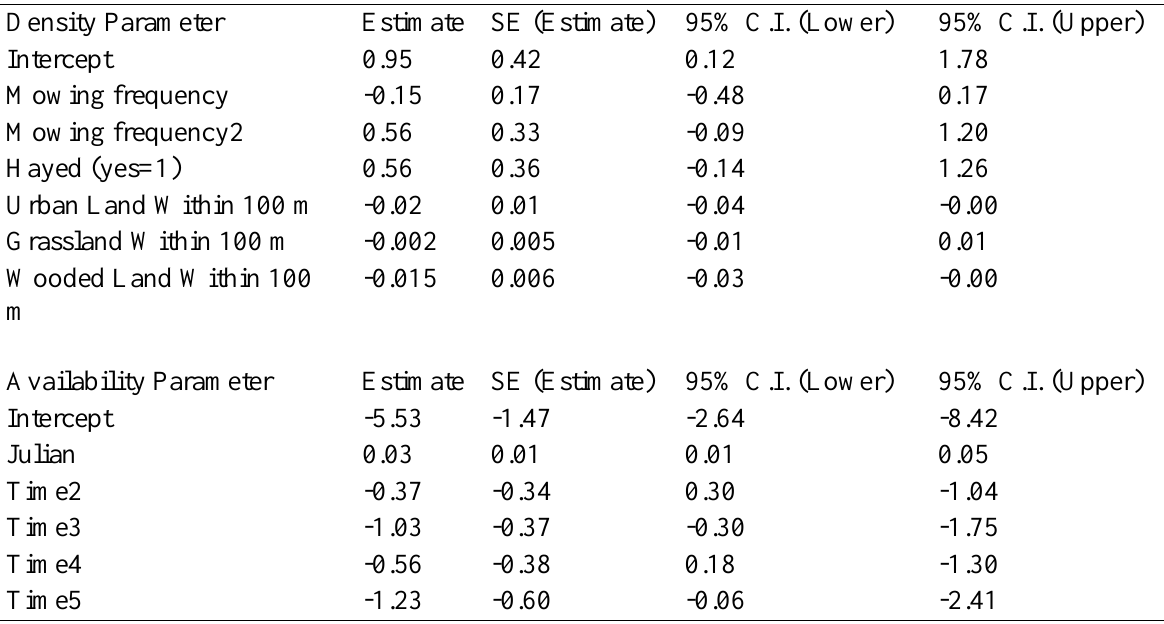
Table A2.G . Third-highest-ranking hierarchical distance-sampling model (AIC ∆ AIC =0.58, AIC weight=0.25) for Clay-coloured Sparrows along 44 transmission line study c sites in Winnipeg, Manitoba, Canada in 2009 (n=132 surveys), assuming a uniform detection probability with increasing distance of birds from the transect line and effects of Julian date and time of morning but not observer experience on availability for